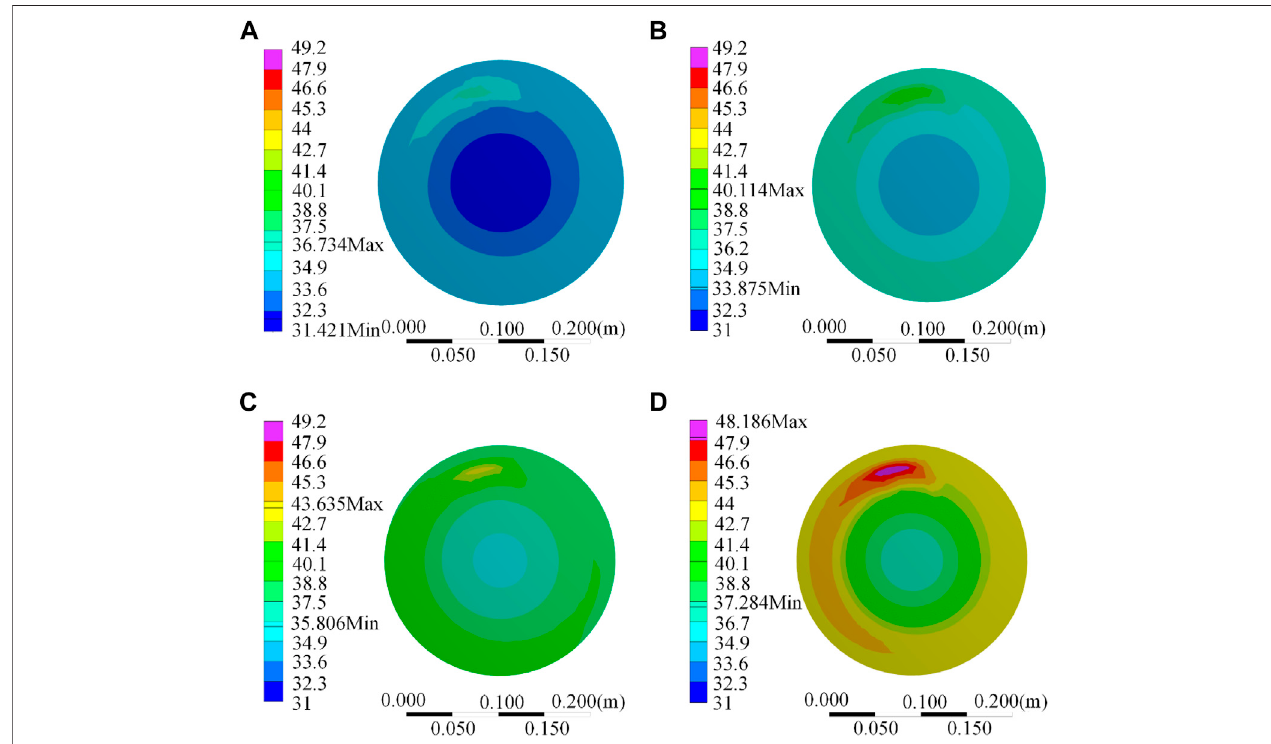
FIGURE 7 | Distribution of the temperature fi eld on the liquid metal lapping-polishing plate with respect to the different rotation speeds in simulation. (A) rp=70 r/ min, (B) rp=100 r/min, (C) rp=130 r/min, (D) rp=160 r/min.